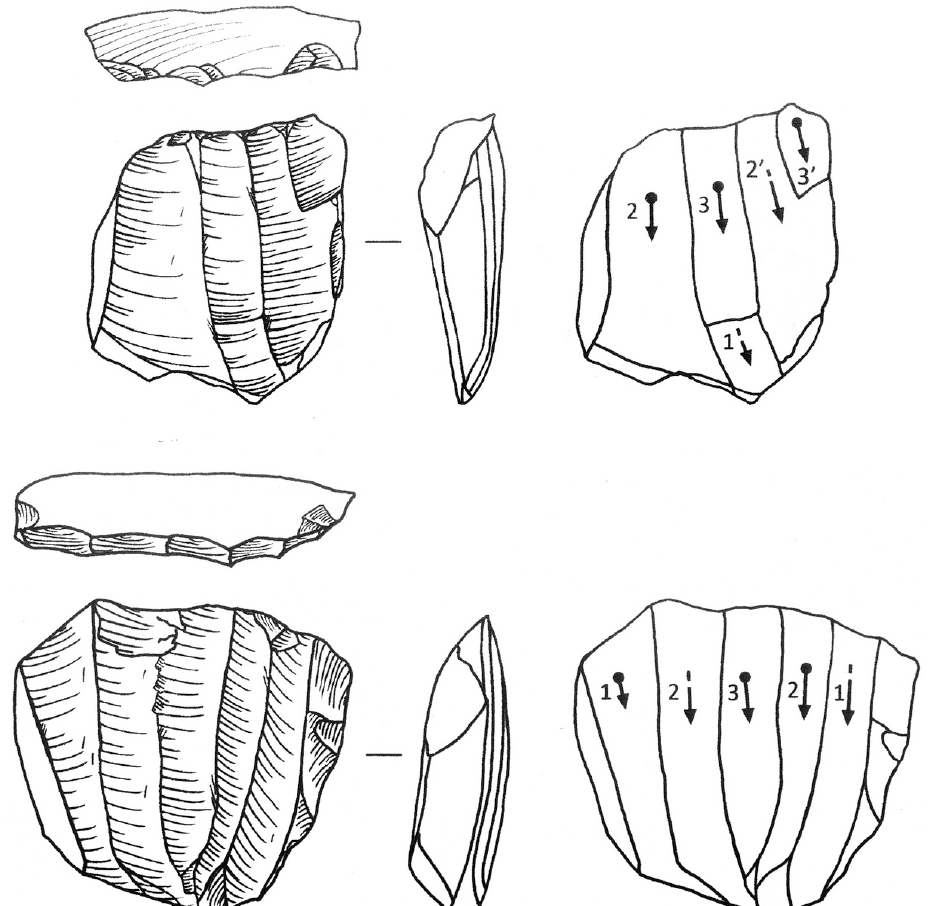
Figure 7. La Bouloie à Crenay (Haute-Marne). Nucléus à débitage frontal et unipolaire avec des plans de frappe lisses très inclinés (dessins: Lautridou 2010) Figure 7. Core with frontal and unipolar debitage with flat inclined striking platform (drawings: Lautridou